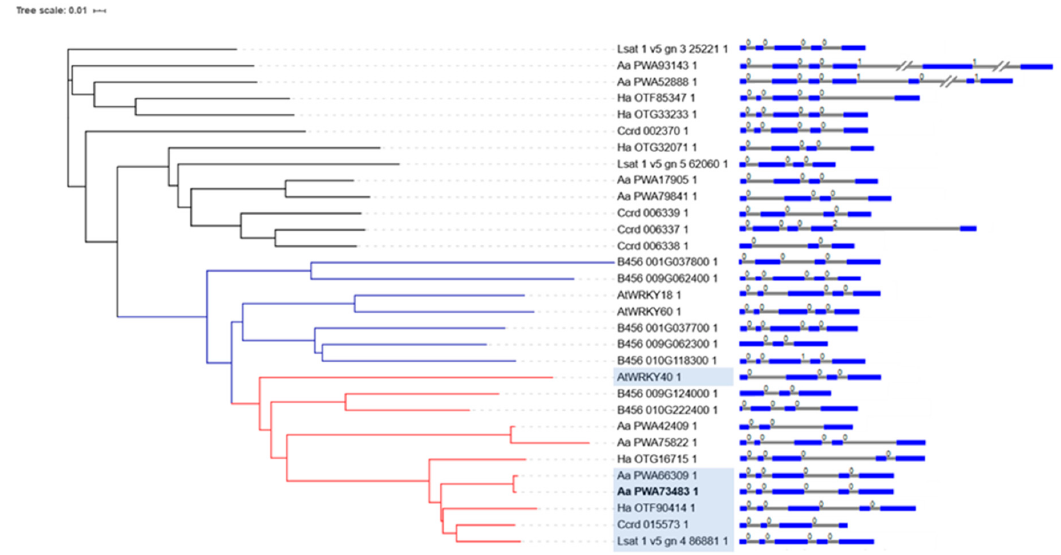
Figure 6. Phylogenetic tree of WRKY proteins from A. annua (Aa), L. sativa (Lsat), C. cardunculus (Ccrd), H. annuus (Ha), A. thaliana (At), and G. raimondii (B456). The complete amino acid sequences of the group IIa WRKY proteins were aligned, and the phylogenetic tree constructed with 1000 bootstrap replicates, using Muscle EMBL-EBI analysis tool [35] followed by visualization with iTOL [36]. The clades containing the WRKY proteins that are more closely related to the well characterized Arabidopsis WRKY18/60, or WRKY40 are highlighted in blue or red, respectively. Genomic exon-intron structure of the genes, shown on the right side, was visualized with PIECE 2.0 [37] exons are in blue, introns in grey.